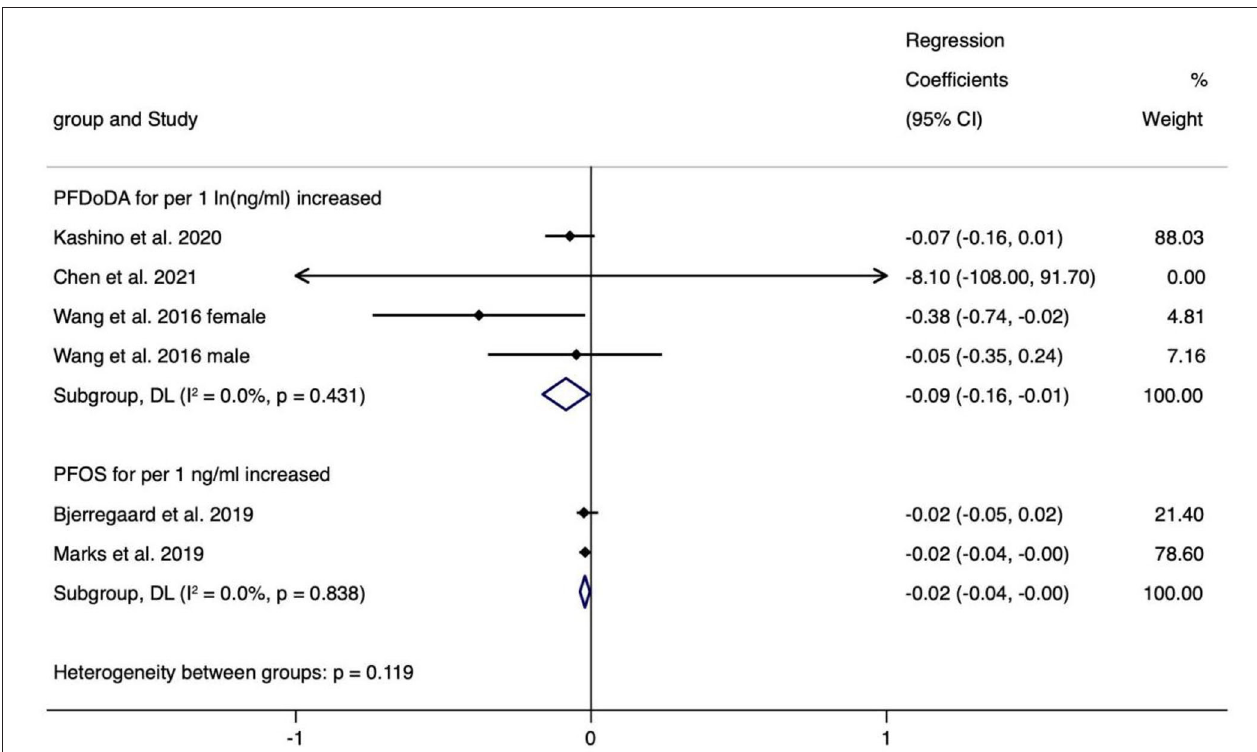
FIGURE 6 | Meta-analysis of the association of PFDoDA and PFOS with head circumference (cm).